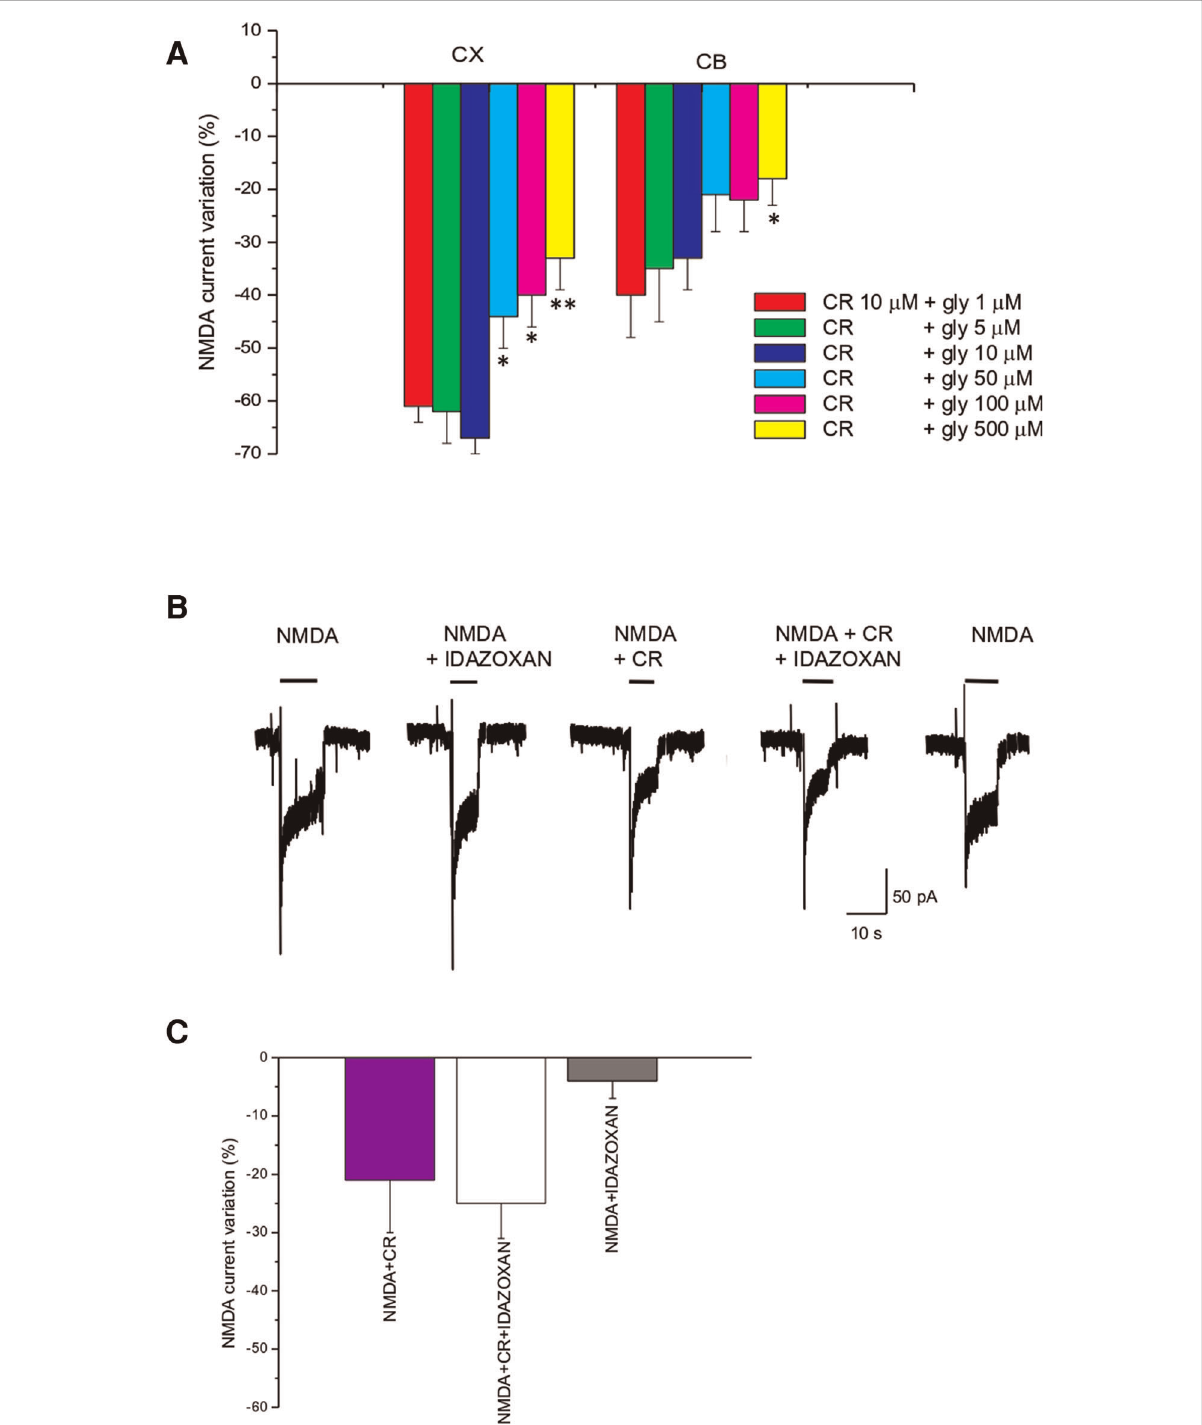
FIGURE 2 CR4056 effect is glycine dependent and is not affected by idazoxan. ( A ) Histogram depicting the effect of 10 µM CR4056 on NMDA-evoked currents (plateau) recorded in cortical (CX) and cerebellar (CB) neuronal cultures in the presence of increasing concentrations of glycine. Histogram bars are the mean±SE ( n =5 – 11). There are statistically signi fi cant differences among groups (One-way ANOVA). Asterisks mean * p <0.05; ** p <0.01, vs. 1 µM glycine ( B ) Electrophysiological recordings showing the effect of idazoxan (10 μ M) on NMDA-evoked currents when is applied alone or together with 10 µM CR4056. Idazoxan did not affect NMDA-elicited current by itself (second trace) and did not block the effect of CR4056 when co-applied with the compound (forth trace). ( C ) Histogram showing the reduction of NMDA current after CR4056, idazoxan and the two compounds together. Histogram bars are the mean±SE ( n =6). No signi fi cative differences were detected ( p >0.05, t